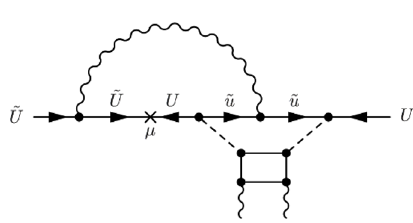
soft breaking 2